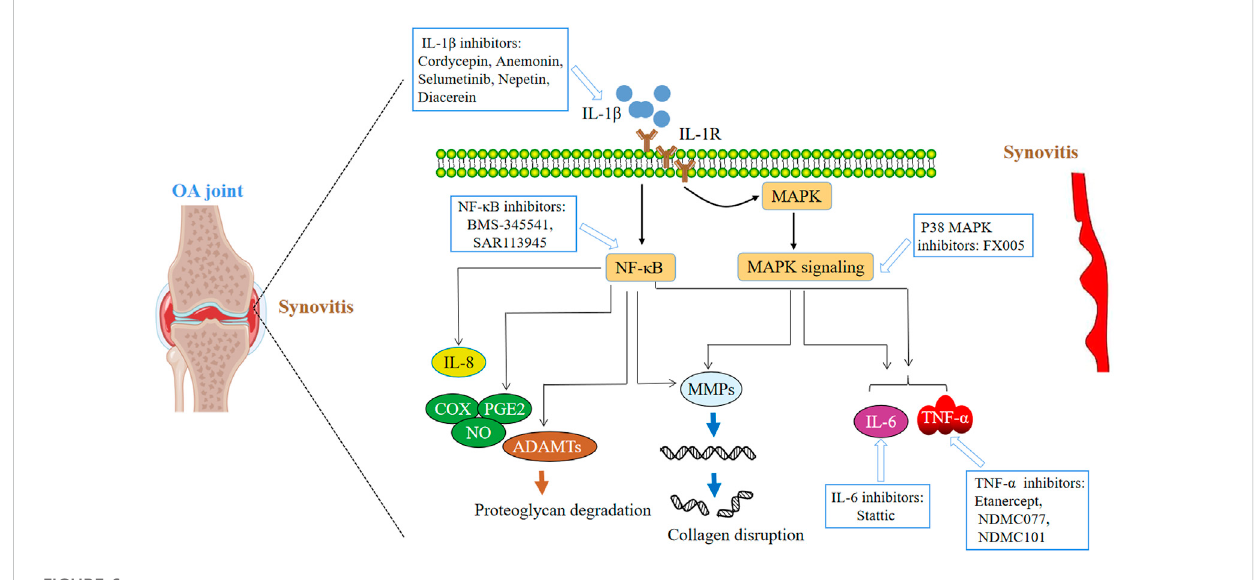
FIGURE 6 Small molecular therapeutic agents focused on in fl ammatory